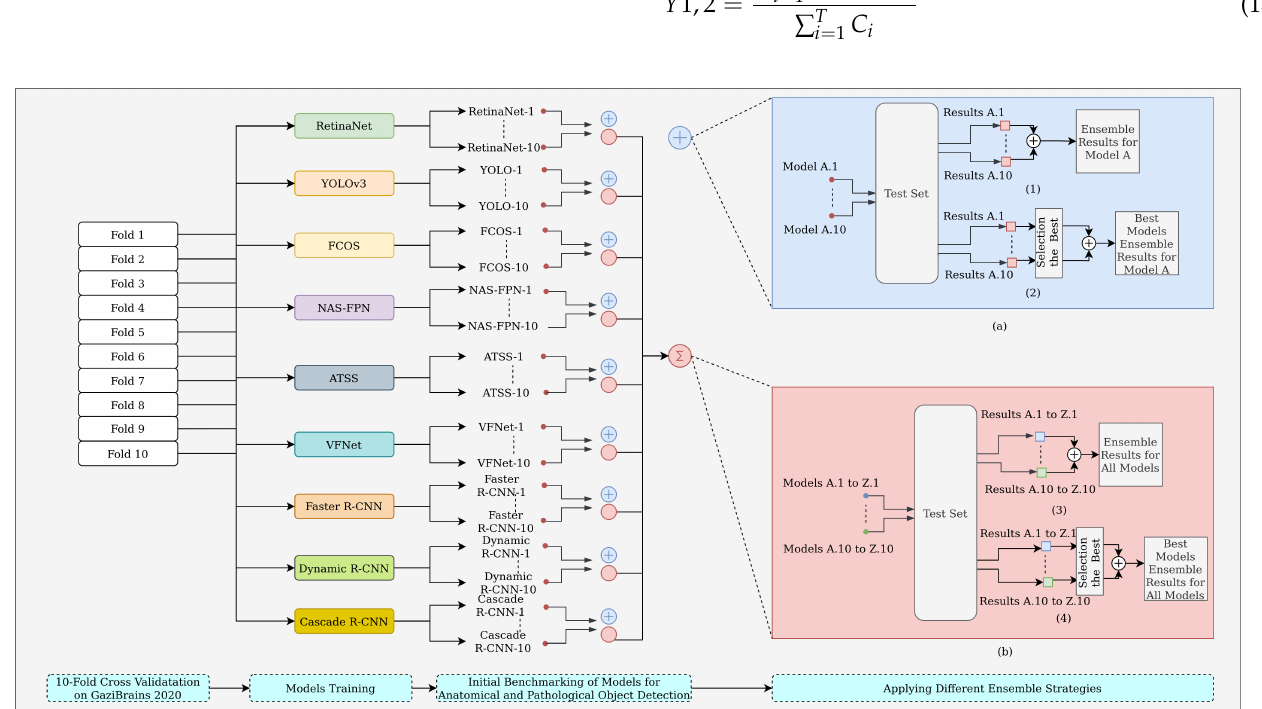
Figure 2. Workflow of the proposed methodology and ensemble strategies for anatomical and pathological object detection: ( a ) An ensemble of different variants of a model; (1) for all folds, Strategy 1, and (2) for the best folds, Strategy 2. ( b ) An ensemble of different models fold-by-fold; (3) for all models, Strategy 3, and (4) for the best different models, Strategy